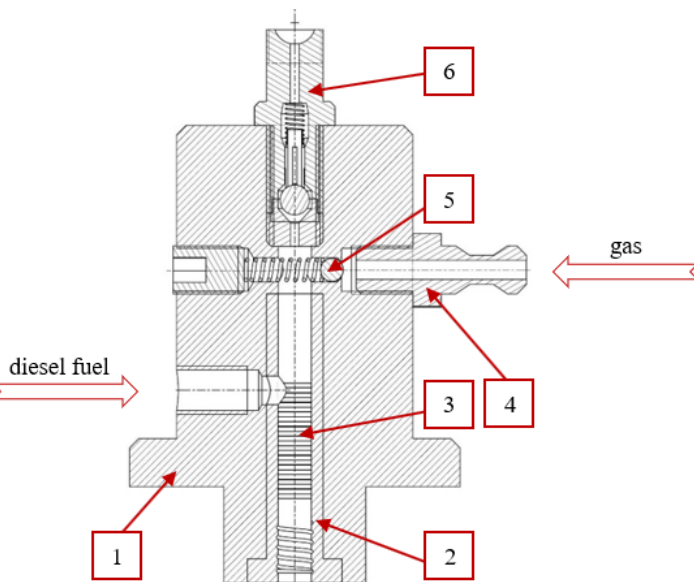
Figure 14. Delivery section of hypocycloid pump: 1—body of the delivery section, 2—cylinder, 3—section labyrinth seal, 4—gas stub pipe, 5—one-way gas valve, 6—one-way outlet valve [44].